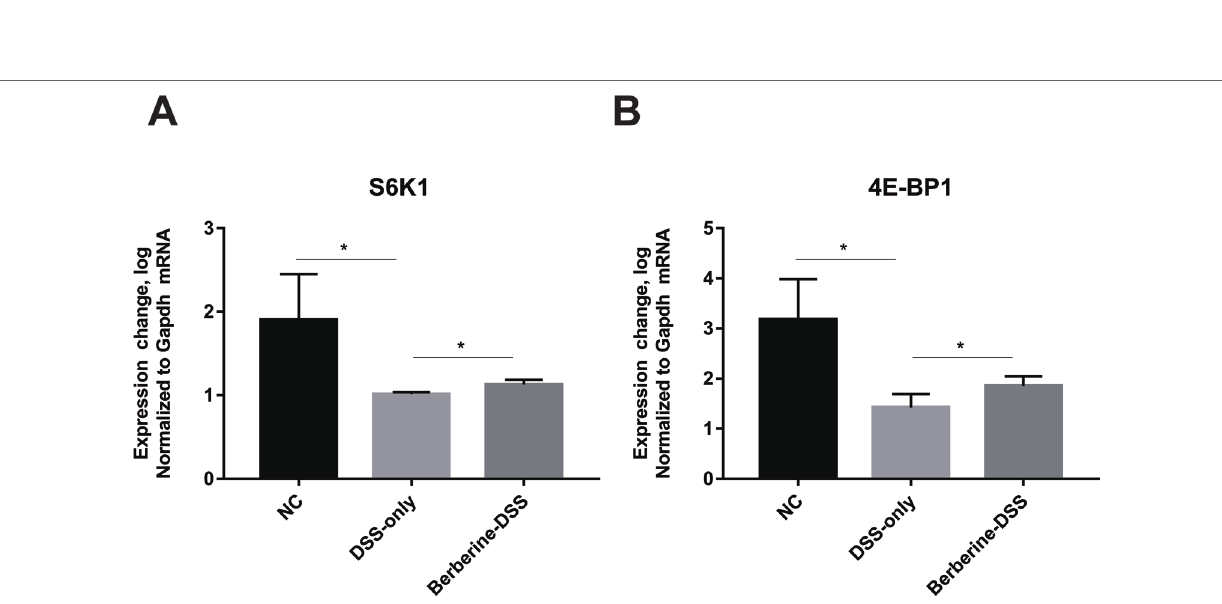
FIGURE 6 | Effect of berberine on the mTORC1 pathway. The relative expression levels of gene S6K1 (A) and 4E-BP1 (B) . Data were pooled from two independent experiments with n = 7 mice per group. * P <